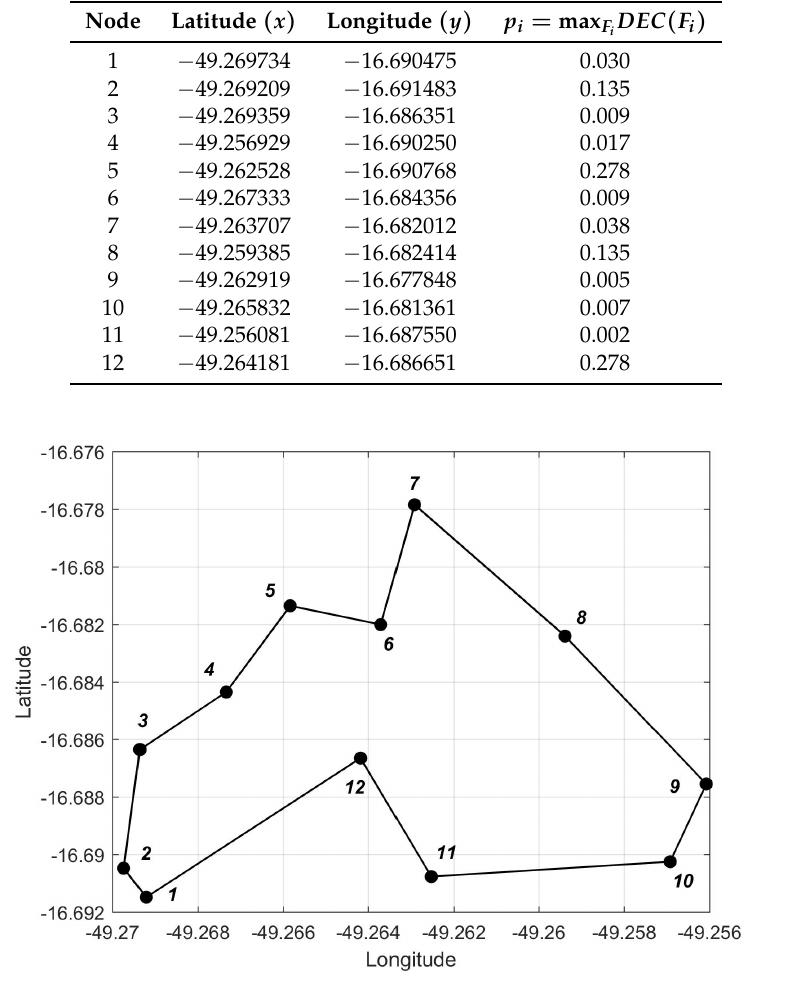
Figure 1. Breaker coordinates and reference ring